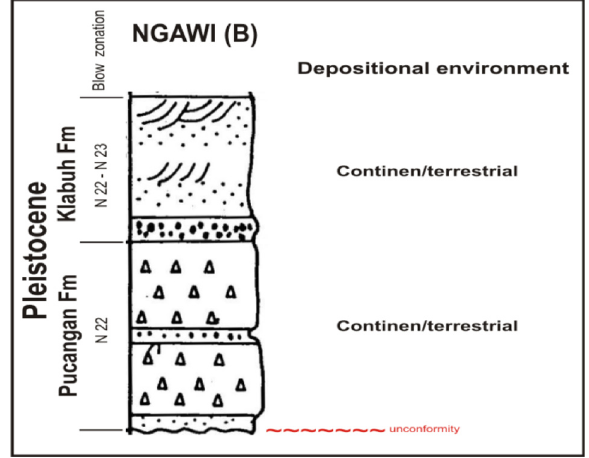
Figure 8. Pucangan and Kabuh Formations at Ngawi B